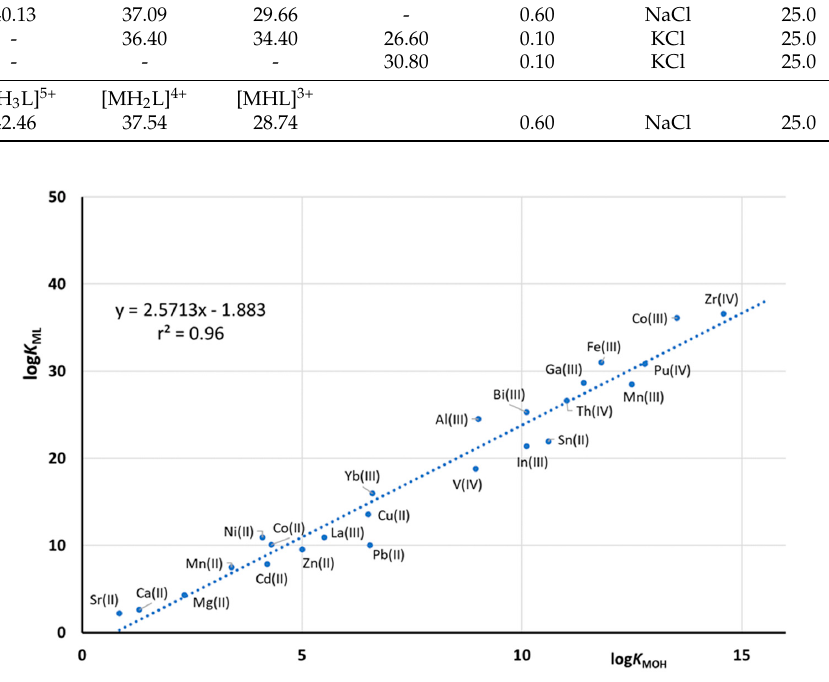
Figure 4. Correlation between the values of log K ML for DFOB complexes in function in the corre- sponding first hydrolysis constant (log K MOH ). The equilibrium constants of the complex are reported in Tables 2–7, while the hydrolysis data are taken from the literature [35,36]. A further method of comparing the stability of the different DFOB metal complexes is based on the two parameters pM and K D . pM is defined as the negative logarithm of the free metal ion concentration in a solution containing a total amount of 10 − 5 moles·dm − 3 of the ligand and 10 − 6 moles·dm − 3 of the metal ion, at pH 7.4 [37]. K D is the dissociation con- stant referring to the hypothetical equilibrium: ML = M + L, where M represents the metal ion, L is the ligand and the charges are omitted for simplicity. The dissociation constant